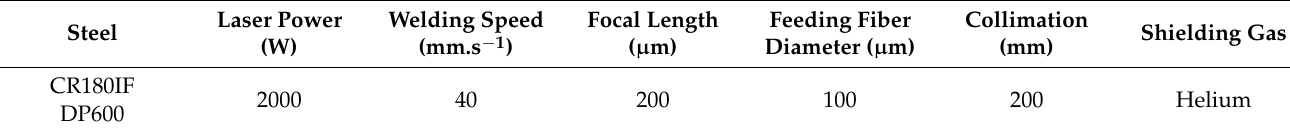
Table 2. Parameters of laser welding by solid-state fiber laser YLR 4500.